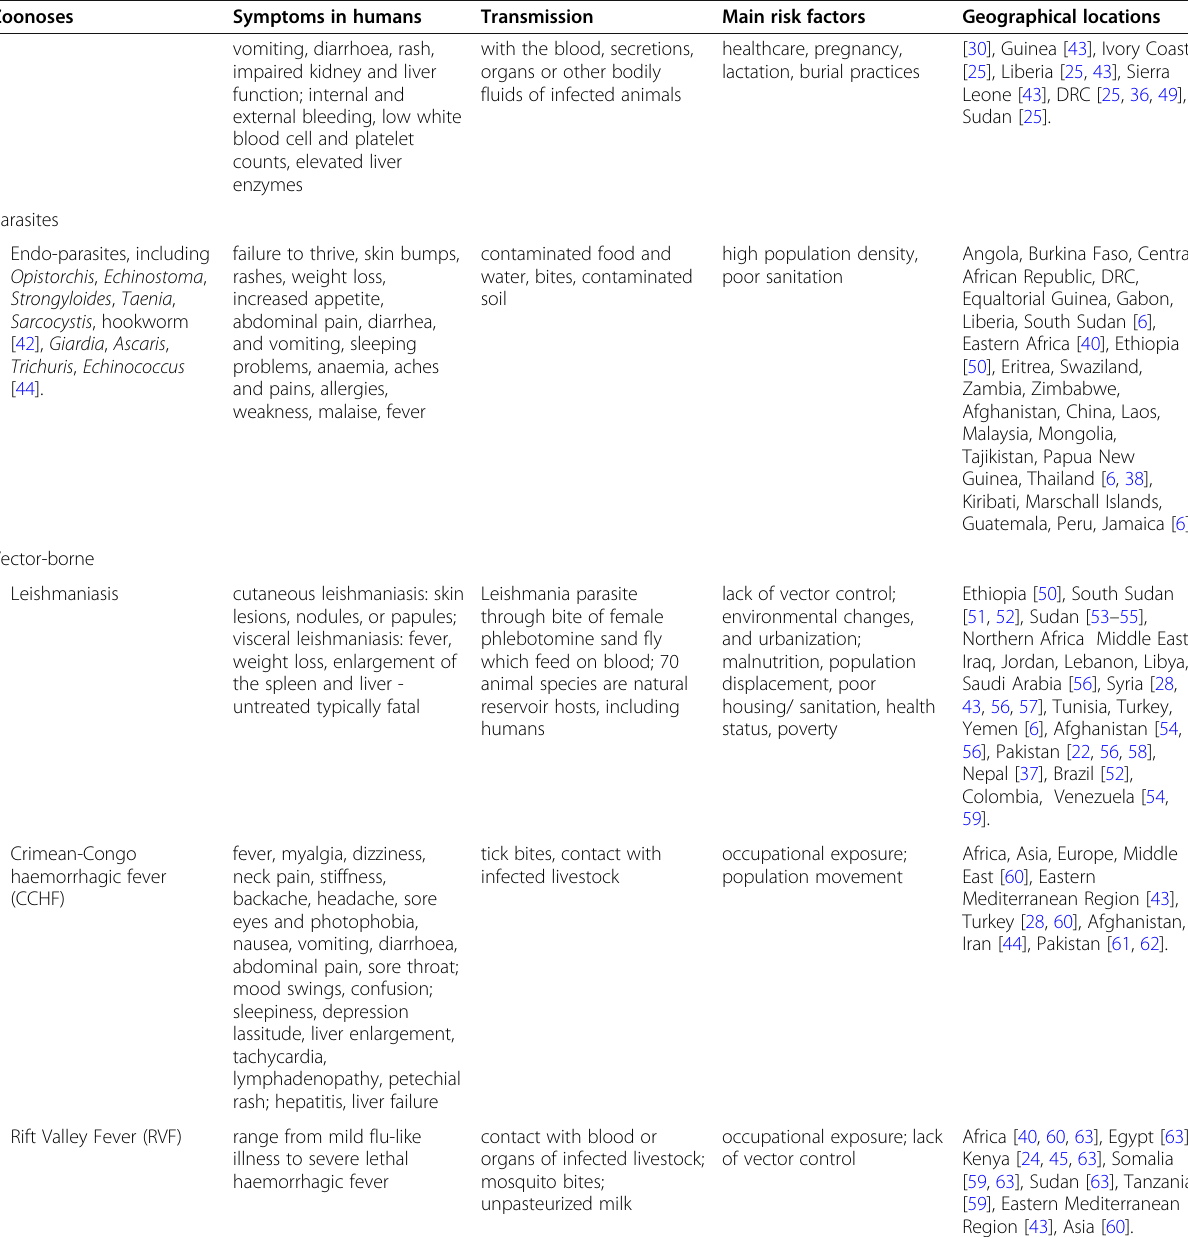
Table 1 Zoonotic diseases of concern in humanitarian emergencies and displacement (identified in the literature reviewed), disease data from: WHO communicable disease control in emergencies, A field manual [28] (Continued)